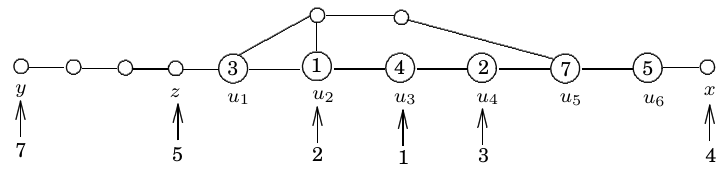
Figure 1: Showing that P